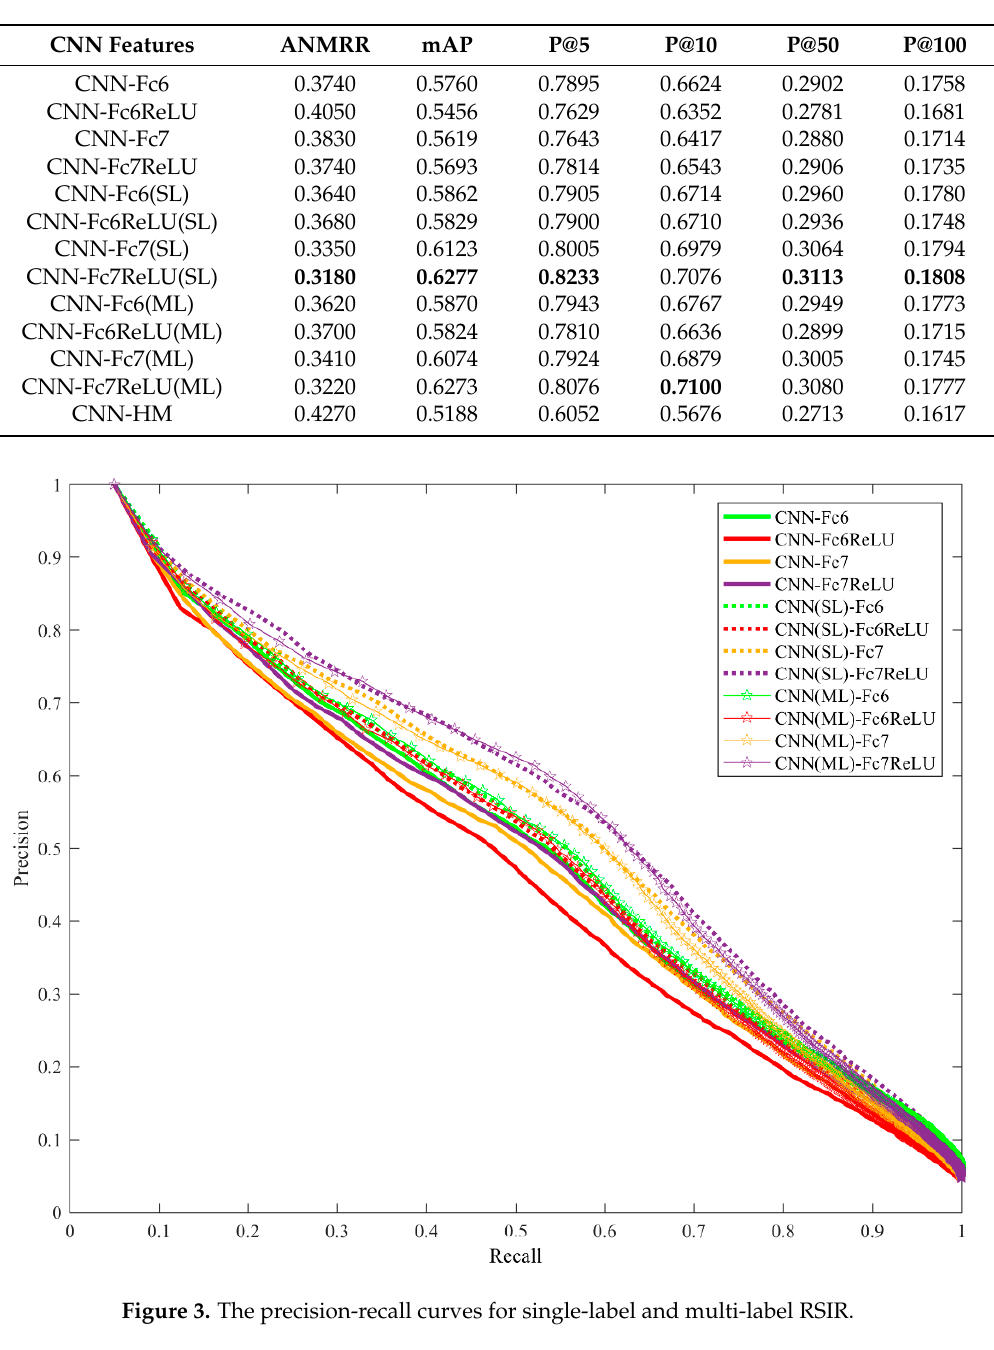
Table 4. Performance of single-label and multi-label RSIR based on CNN features. “SL” and “ML” mean the CNNs are fine-tuned with single and multiple labels, respectively. “ReLU” means the feature is extracted with the use of activation function. The bold values mean the best result for each performance metric.